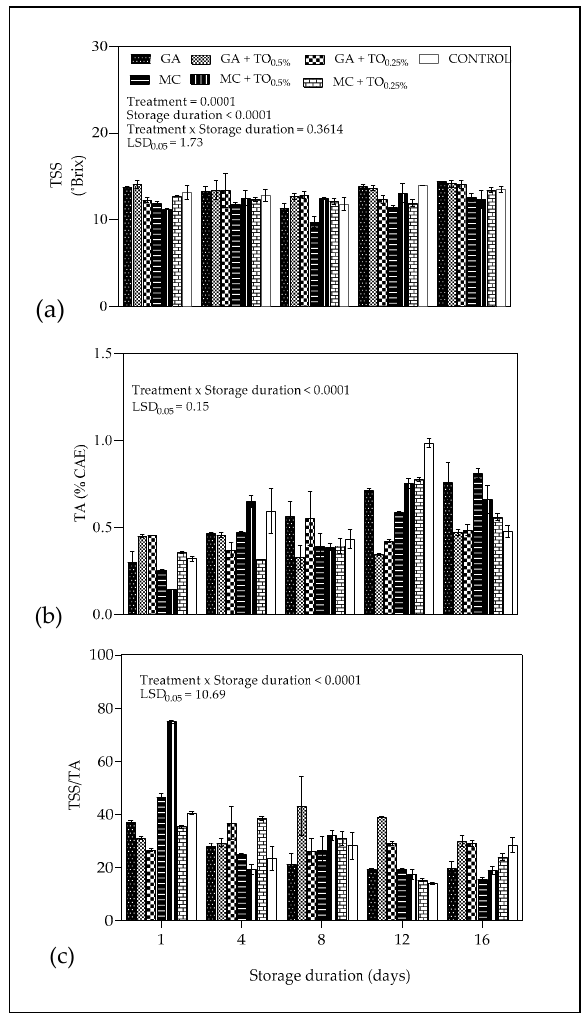
Figure 4. ( a ) Total soluble solids ( ⁰ Brix), ( b ) titratable acidity (% citric acid equivalents) and ( c ) TSS/TA ratio of “Acco” pomegranate arils coated with gum arabic and methyl cellulose coatings enriched with thyme oil (0.5% and 0.25%) and stored at 5 ± 1 °C (95 ± 2% RH) for 16 days. Vertical bars represent the standard error (SE) of mean values of three replicates. LSD 0.05 represent least significant difference ( p < 0.05).